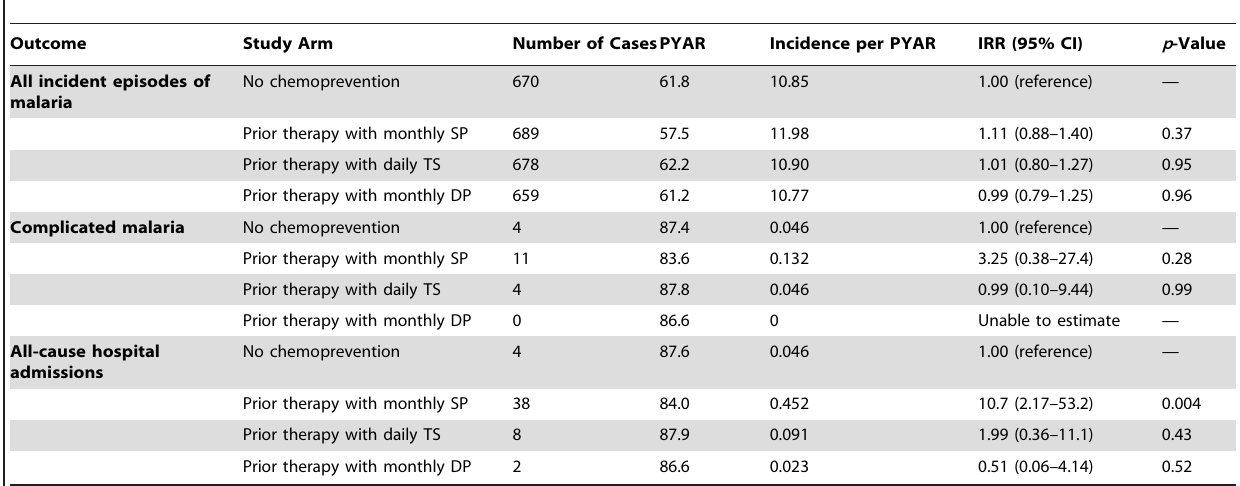
Table 6. Comparative outcomes after intervention was stopped (24–36 mo of